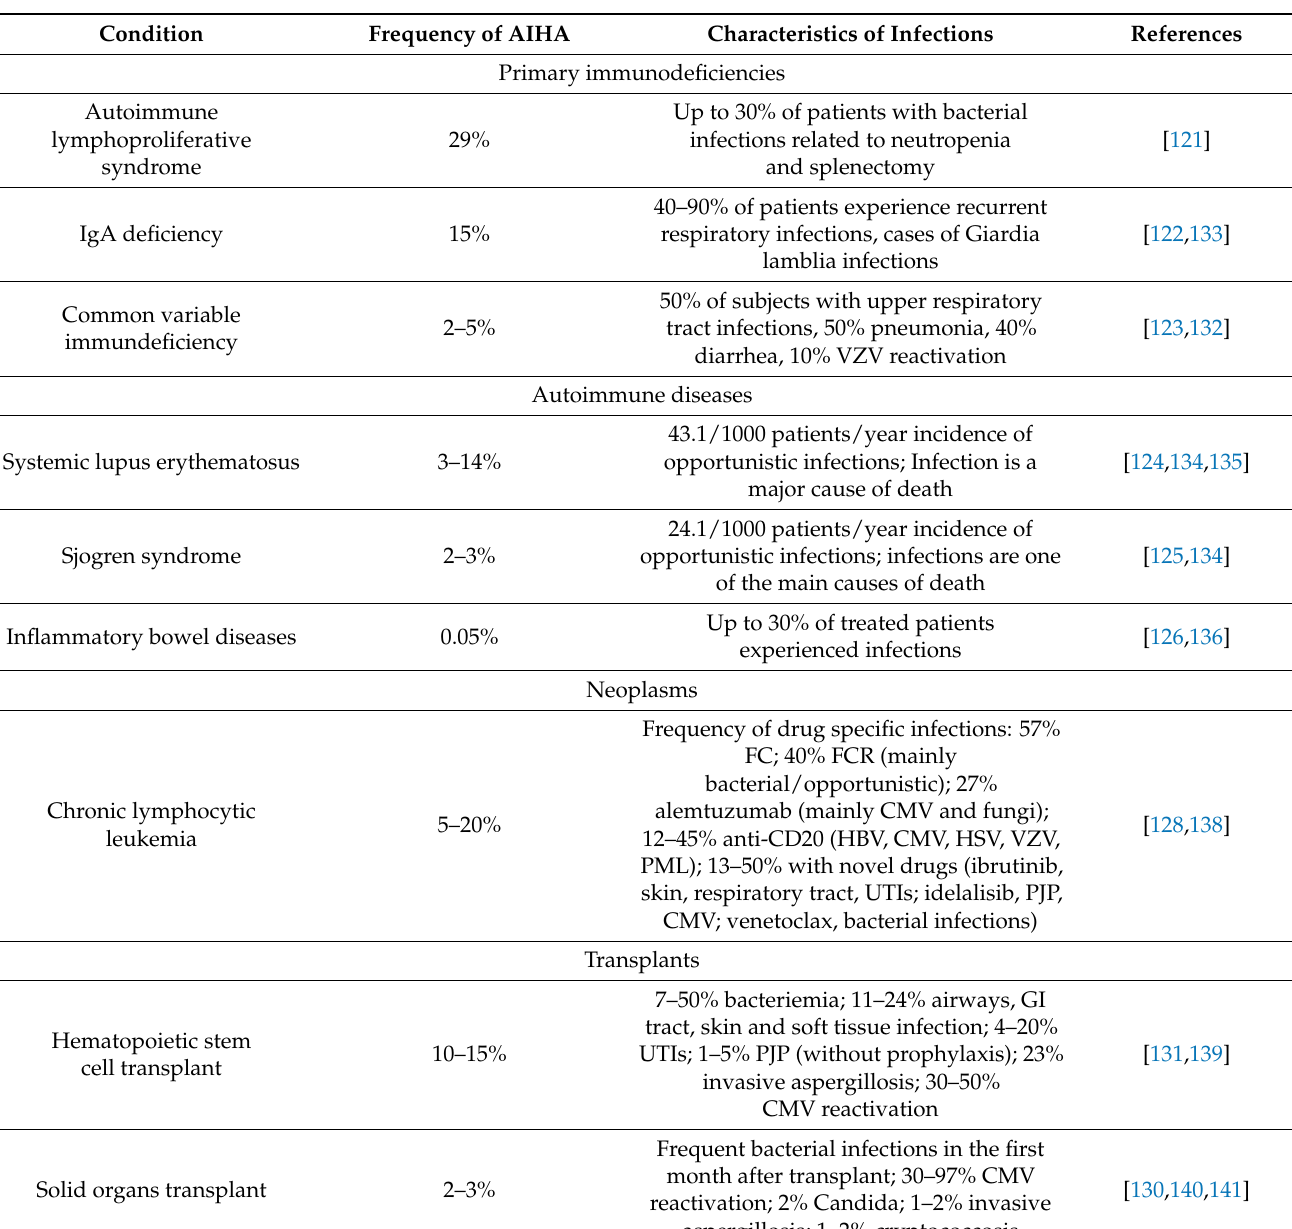
Table 5. Infectious risk in conditions associated with AIHA.